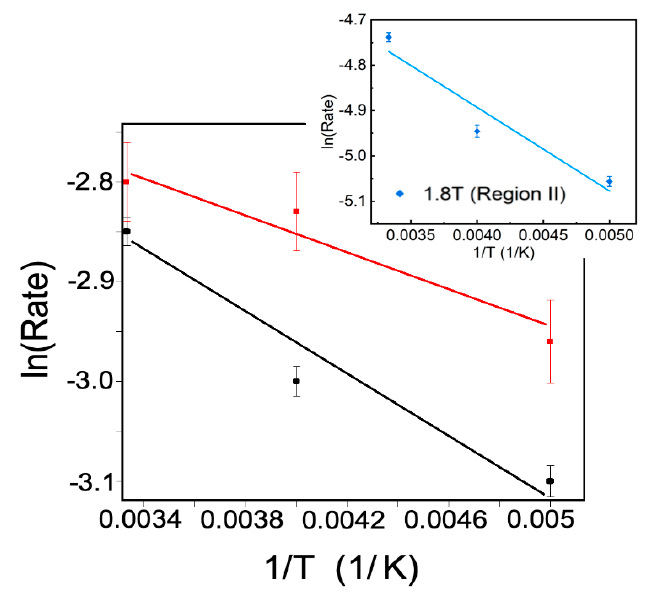
Figure 5. The temperature-dependent Arrhenius plots of the conversion rate to a high-spin state for [Fe{H 2 B(pz) 2 } 2 (bipy)] thin films on NiCo 2 O 4 (111), induced by a soft X-ray fluence. In the absence of an applied magnetic field, this temperature dependence indicates a thermal component of the activation energy of 14.5 ± 1.5 meV (black). The Arrhenius plot for the initial period when 1.8 T external magnetic field is applied (region I, Figure 2) suggests a thermal component of the activation energy of 7.2 ± 2 meV (red). The inset is the Arrhenius plot for the following 1.8 T transition to the high-spin state when a significant fraction of the [Fe{H 2 B(pz) 2 } 2 (bipy)] thin film on NiCo 2 O 4 (111) has converted to the high-spin state (region II, Figure 2) and indicates a thermal component of the activation energy of 15.9 ± 2.7 meV (blue).